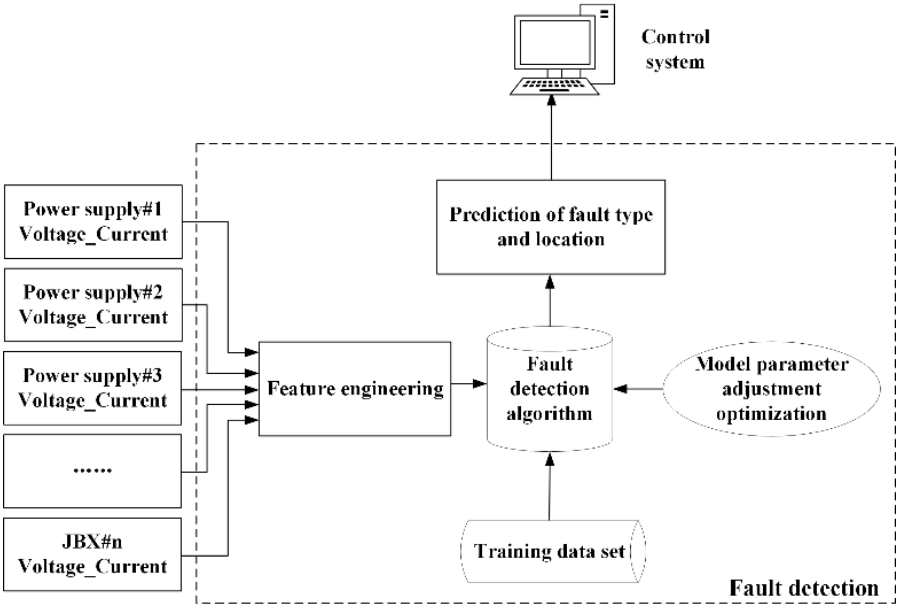
Figure 3. Flowchart of fault detection.